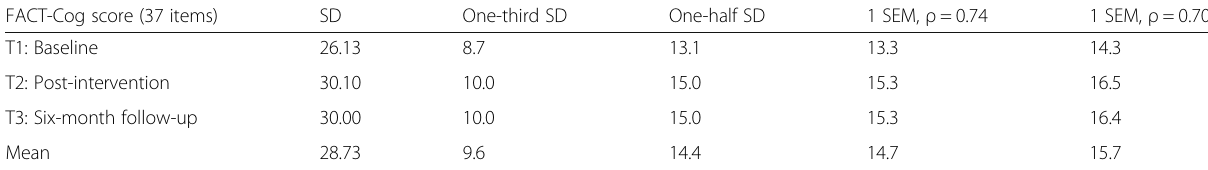
Table 7 Distribution-based CID (SD multiples) and MCT lower limit (SEM) estimates for the 37-item FACT-Cog total score based on changes from post-intervention and six month follow-up FACT-Cog score (37 items) SD One-third SD One-half SD 1 SEM, ρ = 0.74 1 SEM, ρ =